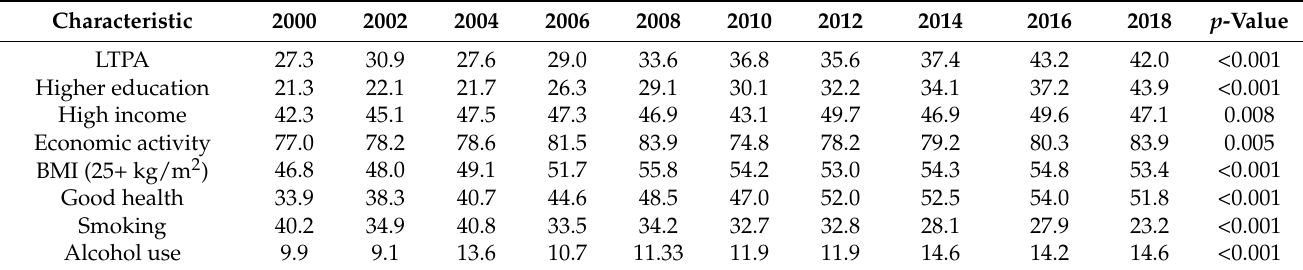
Table 2. The prevalence (%) of outcome and explanatory variables among adults in Estonia, 2000–2018.